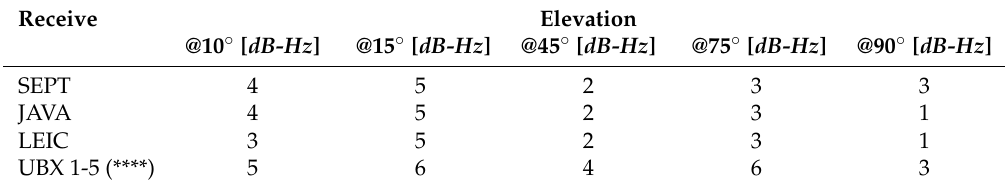
Figure 4. Signal characteristics of the analysed receivers for GPS ( a – d ) and GLONASS ( e – h ) of frequency L1 on the C/A signal. Table 2. C/N0 deviations in [ dB-Hz ] over elevation bins of 5 ◦ for a 24 hour data set (DOY 067, 2018). The asterisks for the receiver UBX identifying all the analysed individual